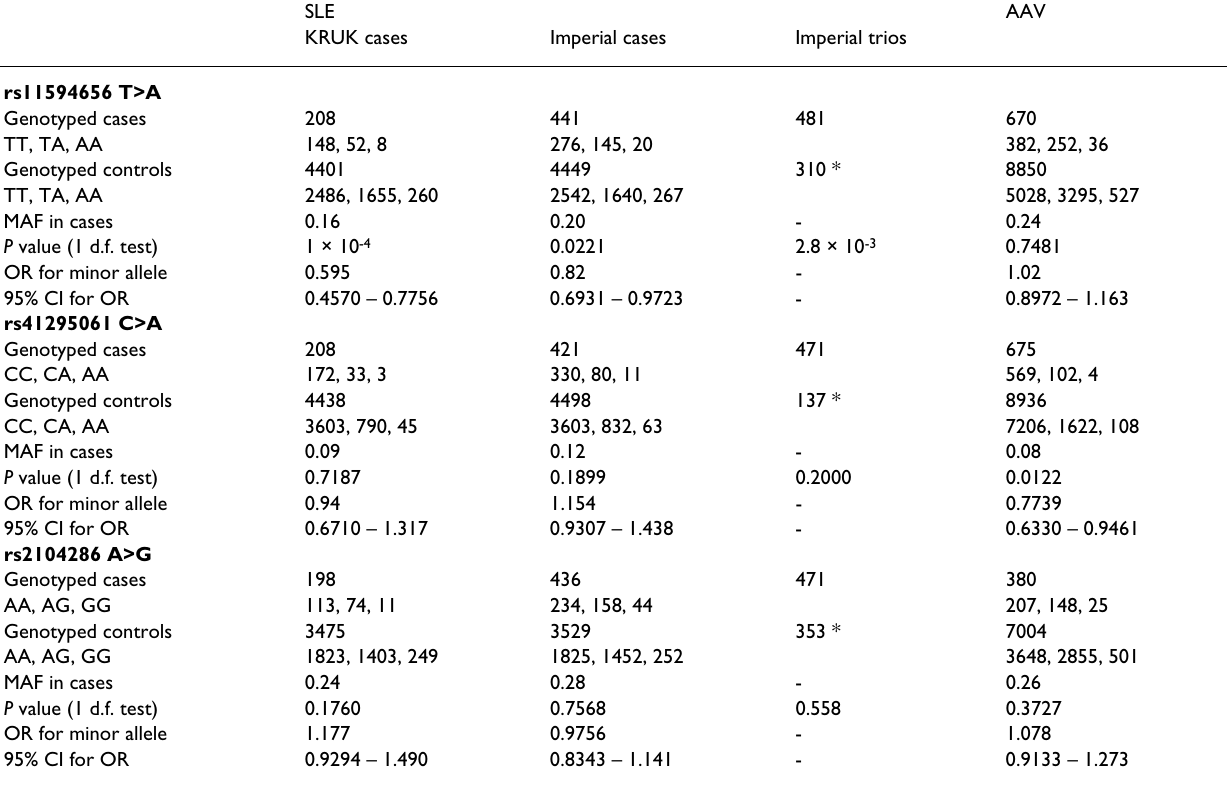
Table 1: Genotype data at rs11594656, rs41295061 and rs2104286 for SLE and AAV SLE